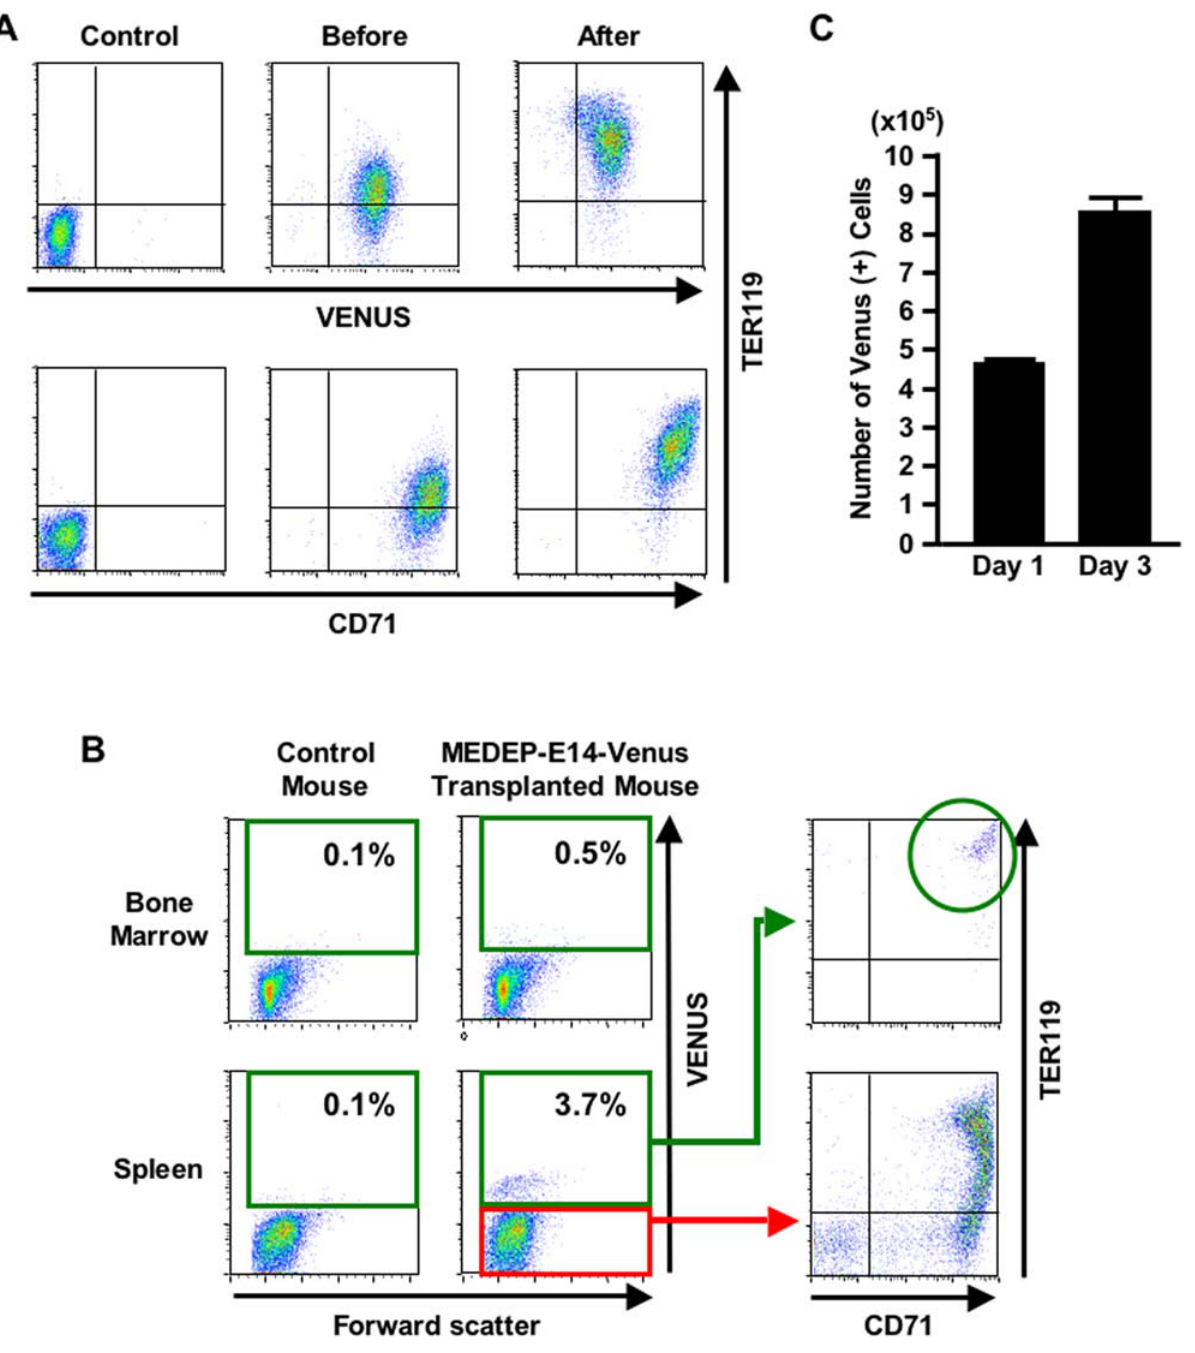
Figure 3. In vivo proliferation and differentiation of MEDEP. A transformant of MEDEP-E14 expressing Venus as a marker was established, MEDEP- E14-Venus. (A) The in vitro differentiation of MEDEP-E14-Venus was performed by culture for two days after deprivation of erythropoietin. Control, results with isotype controls. Before and After, the cells before and after in vitro differentiation. (B) In vivo differentiation of MEDEP-E14-Venus cells. Acute anemia was induced in an immuno-deficient mouse (NOD-SCID) and the next day MEDEP-E14-Venus cells (2 6 10 7 cells/mouse) were transplanted into the anemic mouse. Three days after cell transplantation, bone marrow and spleen cells were subjected to flow cytometric analyses. Control mouse, NOD-SCID mouse without cell transplantation. The vast majority of Venus-positive cells in the spleen show differentiation into CD71 + TER119 + mature erythroid cells. (A, B) CD71 and TER119, see legend of Figure 2A. Results shown are representative of three independent experiments. (C) In vivo proliferation of MEDEP-E14-Venus cells. Cell transplantation was performed as in (B). We determined the proportion (%) of Venus-positive cells and calculated the absolute number of Venus-positive cells in the spleen. Day 1 and Day 3, one day and three days following cell transplantation, respectively. Values are mean 6 S.D. (N=3).